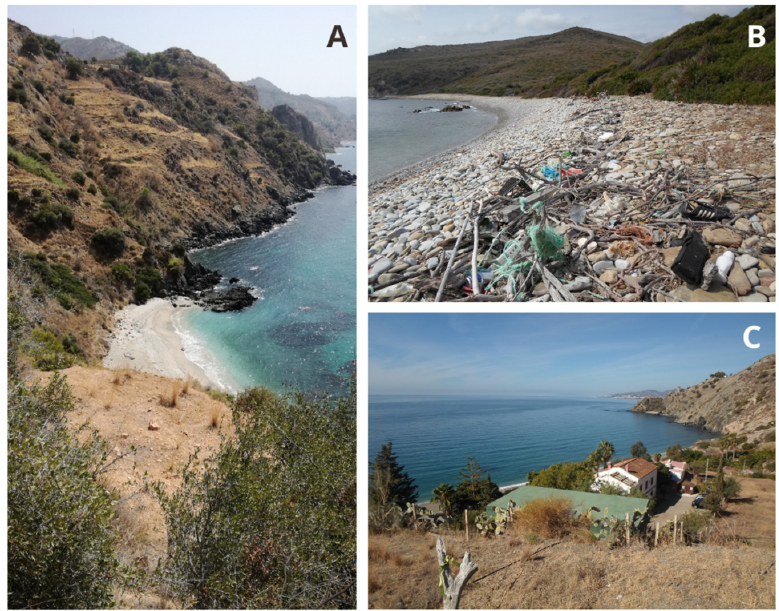
Figure 8. Examples of human scenic categories in Andalusia Mediterranean coast (Spain): Cala Chumbo at Malaga province (Category I, A ); Ensenada del Tolmo at Gibraltar Strait in Cadiz province (Category II, B ); Cala El Cañuelo at Malaga province (Category III, C ).